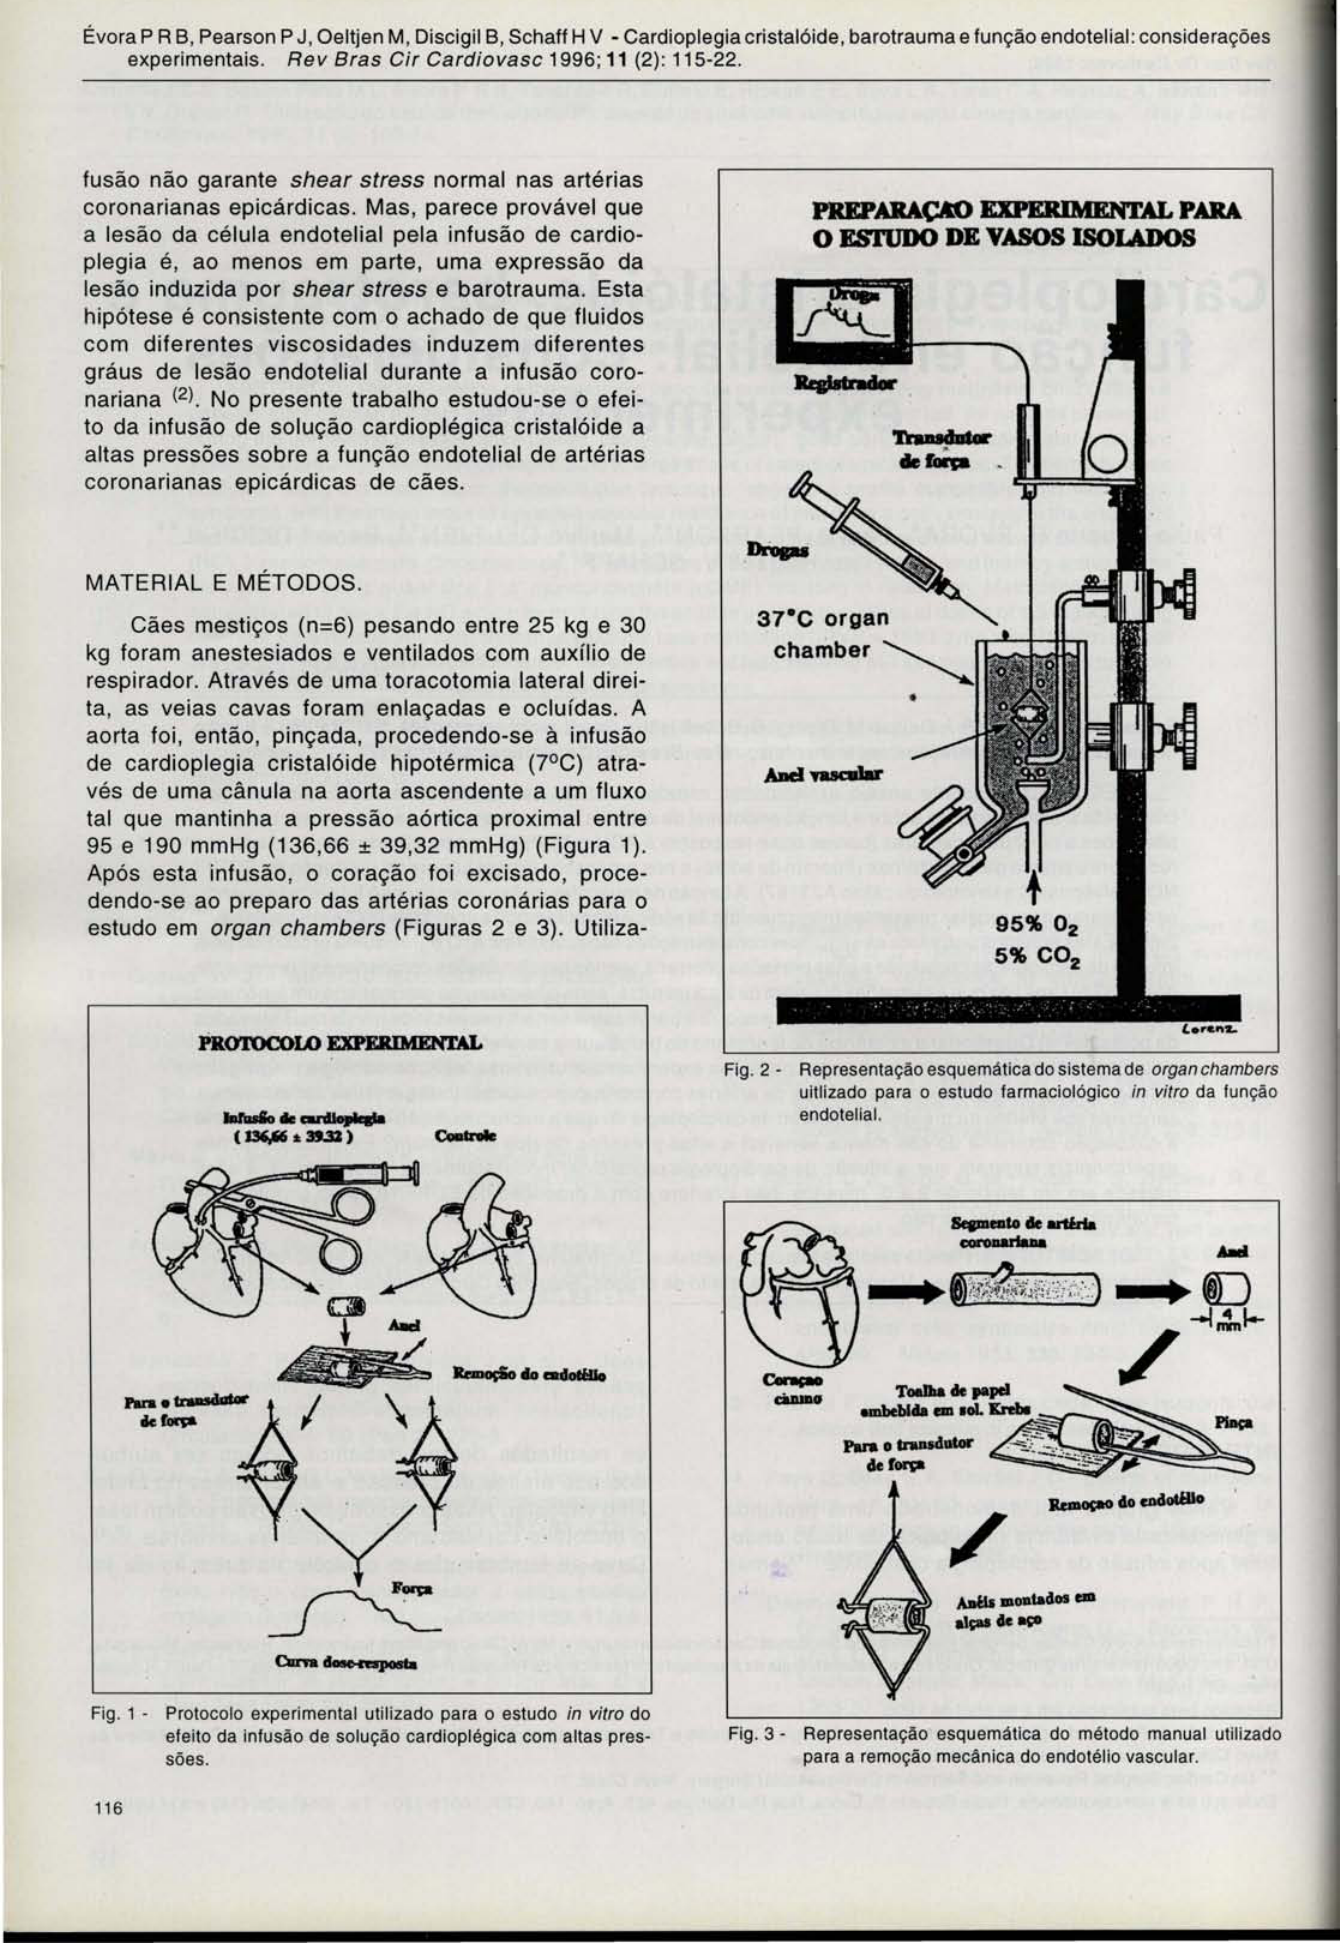
Fig. 3 - Representação esquemática do método manual utilizado para a remoção mecânica do endotélio